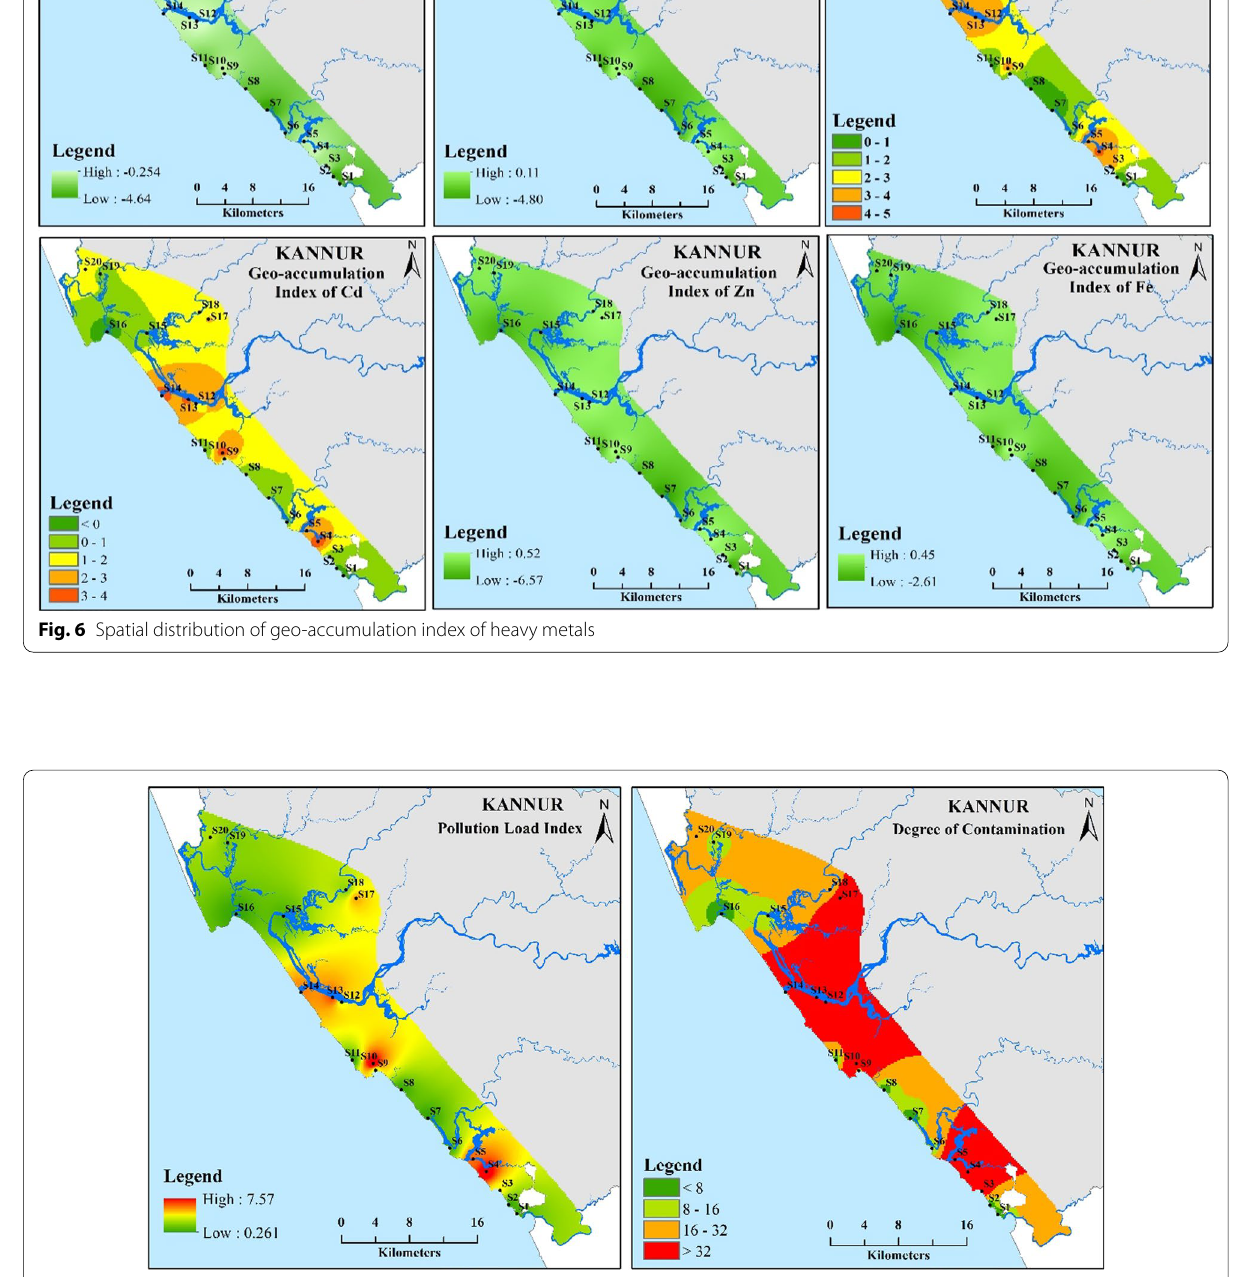
Fig. 7 Spatial distribution of pollution load index and degree of